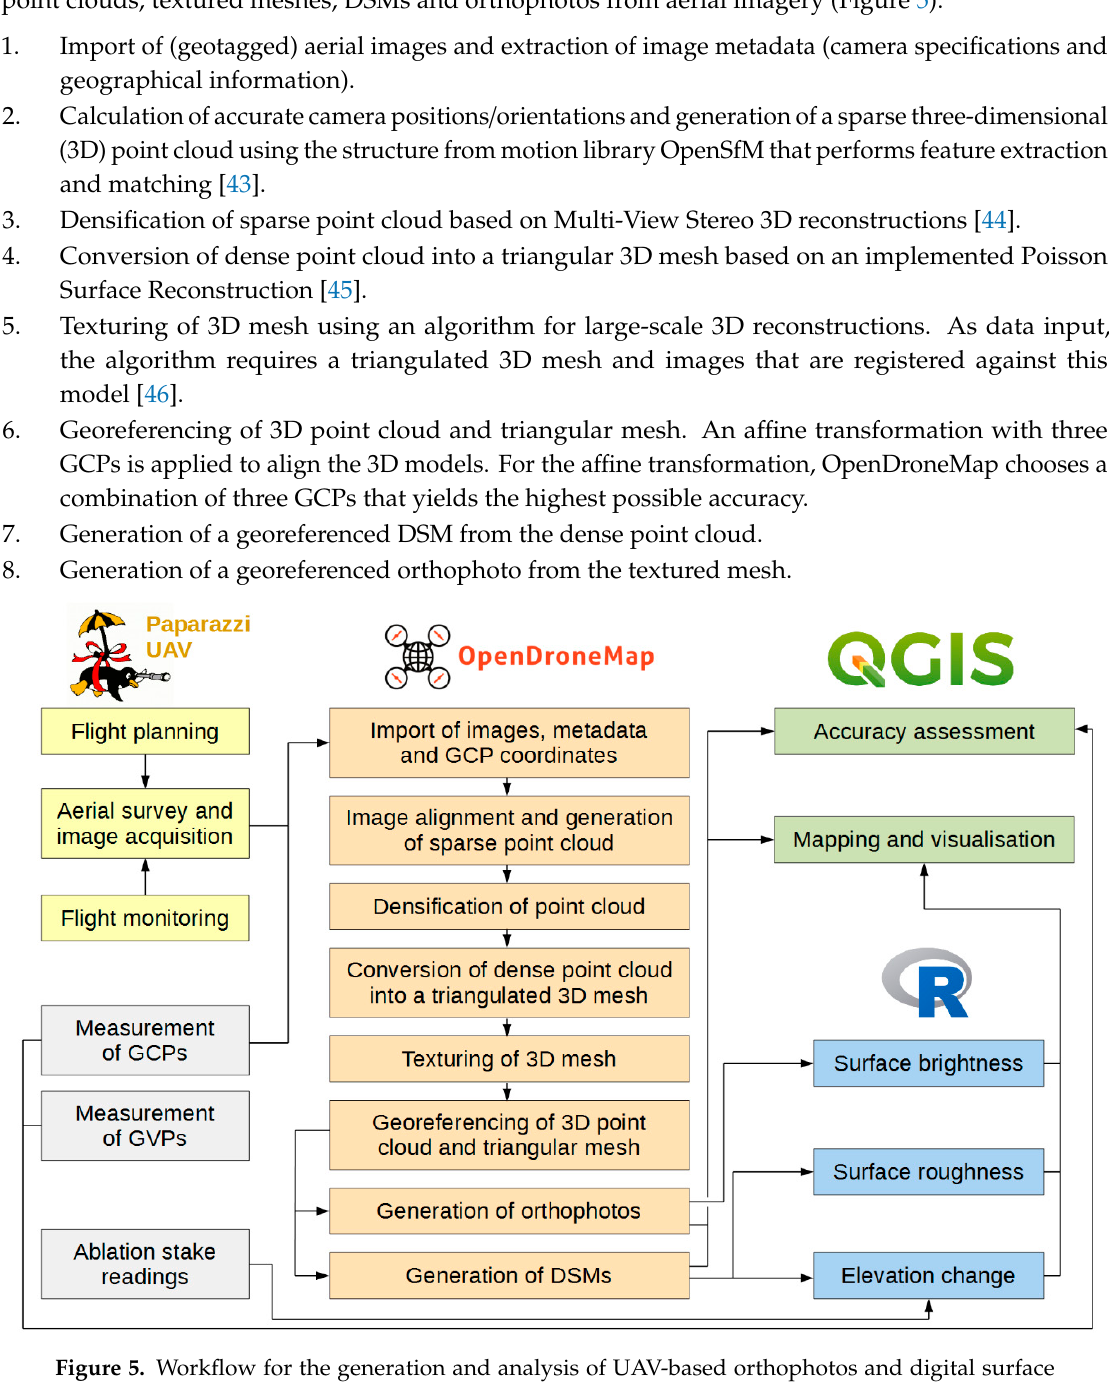
Figure 5. Workflow for the generation and analysis of UAV-based orthophotos and digital surface models using open-source software only.